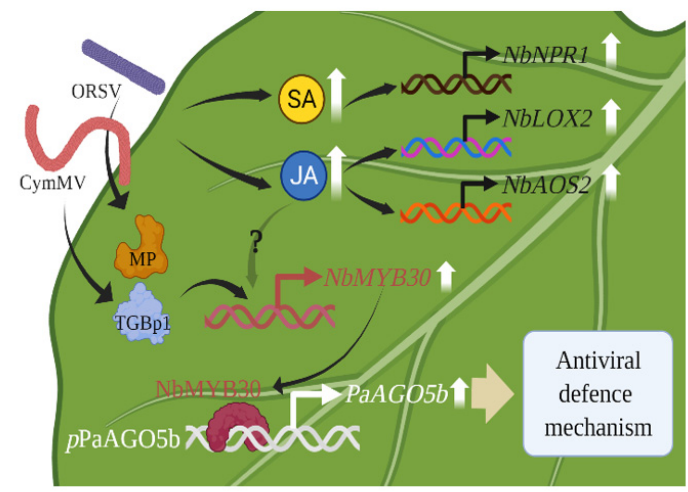
Figure 9. A model for enhancing antiviral defense mechanism through the activation of p PaAGO5b. The CymMV or ORSV infectious clones and their TGBp1, a CymMV-encoded protein, and MP, an ORSV-encoded protein, may upregulate plant defense-related TF NbMYB30. The NbMYB30 TF binds to the p PaAGO5b ( p -indicates the promoter) and transcriptionally activates PaAGO5b expression to enhance the antiviral defense mechanism. During virus infection, phytohormones SA and JA and their marker genes were upregulated. Principally, JA was significantly enhanced; however, upregulation of NbMYB30 under JA enhancement during virus infection has not yet been explored. LOX2 —lipoxygenase 2; AOS2 —allene oxide synthase 2, NPR1 —nonexpressor of pathogenesis-related genes-1.